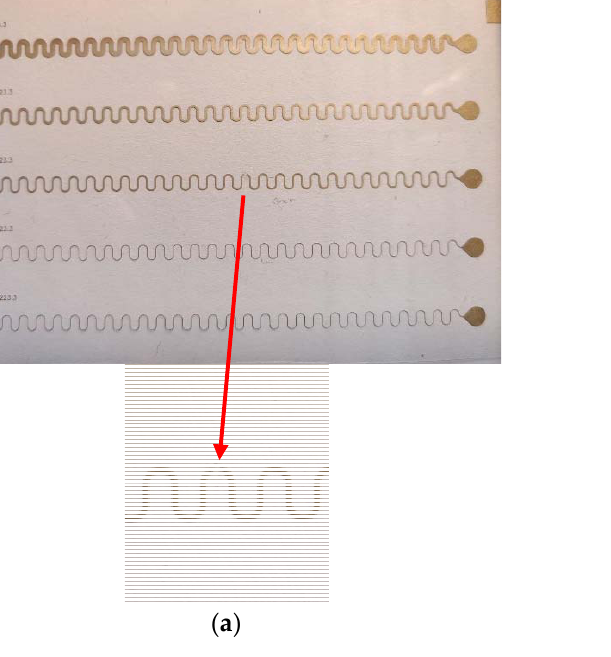
Figure 6. Complete wire breaks on ( a ) Test sample 1—U-shape printing pattern with cut through on the third wire; ( b ) Test sample 2—Straight printing pattern test sample with cut through on the fifth